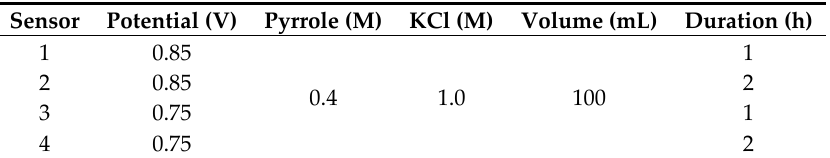
Table 1. PPy(Cl − ) sensors’ growing conditions .